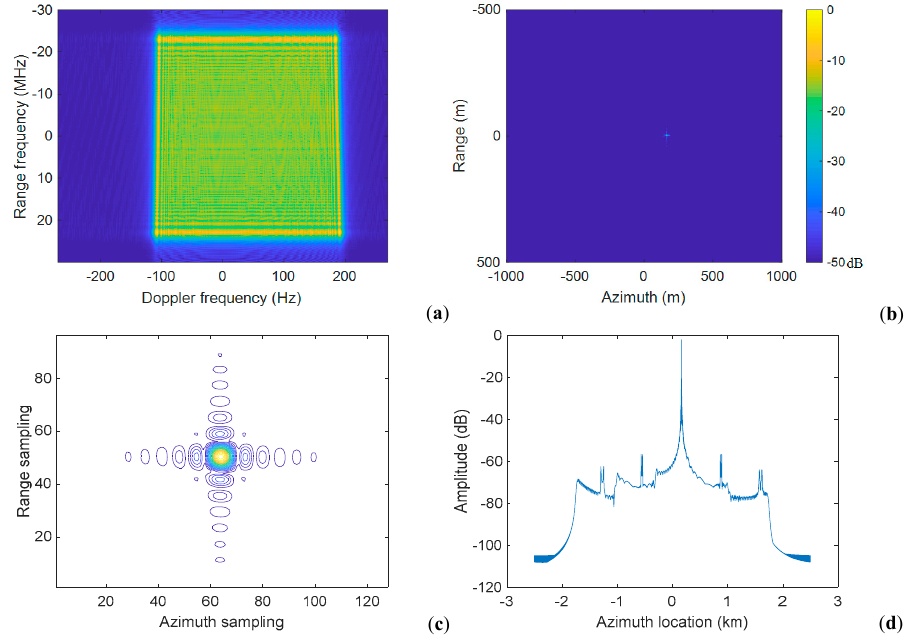
Figure 15. The imaging result via the proposed approach when the slant range velocity is 10 m/s. ( a ) Reconstructed two-dimension spectrum. ( b ) The focused point target. ( c ) Contour plots of the point target. ( d ) The maximum azimuth projection profile.